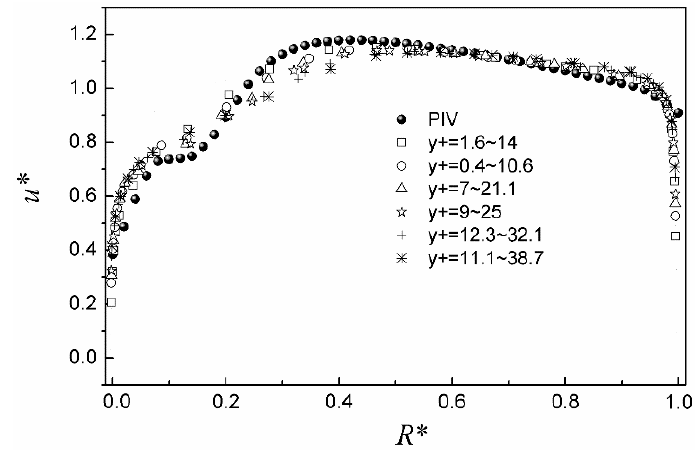
Figure 6. Comparison of PIV and CFD results obtained by different y+ mesh types.